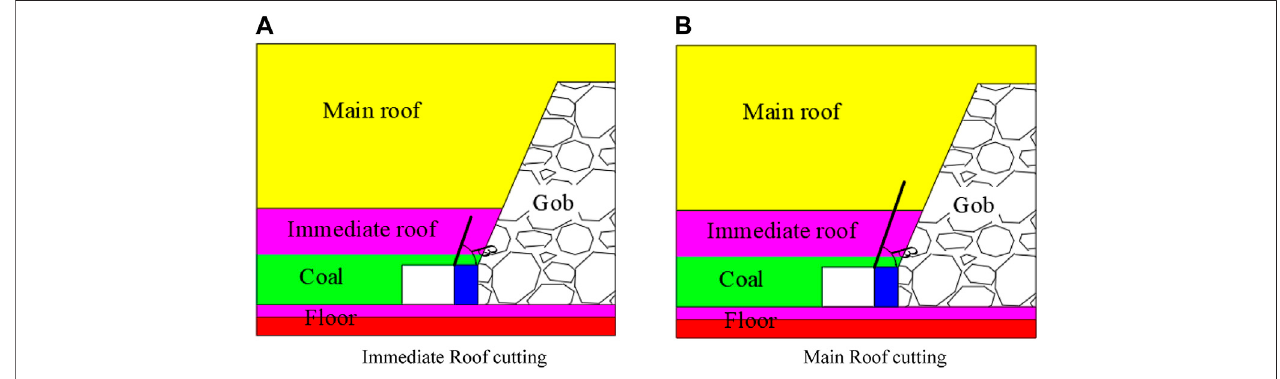
FIGURE 10 | Simulation schemes. (A) Immediate roof cutting (B) Main roof cutting.